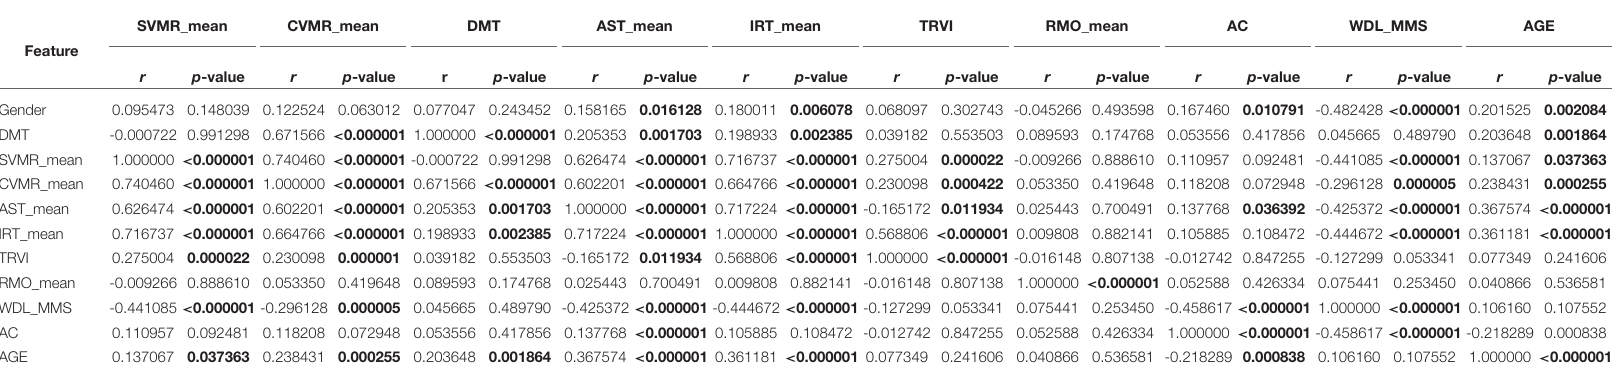
TABLE 1 | Correlation matrix of psychophysiological tests performance and age.